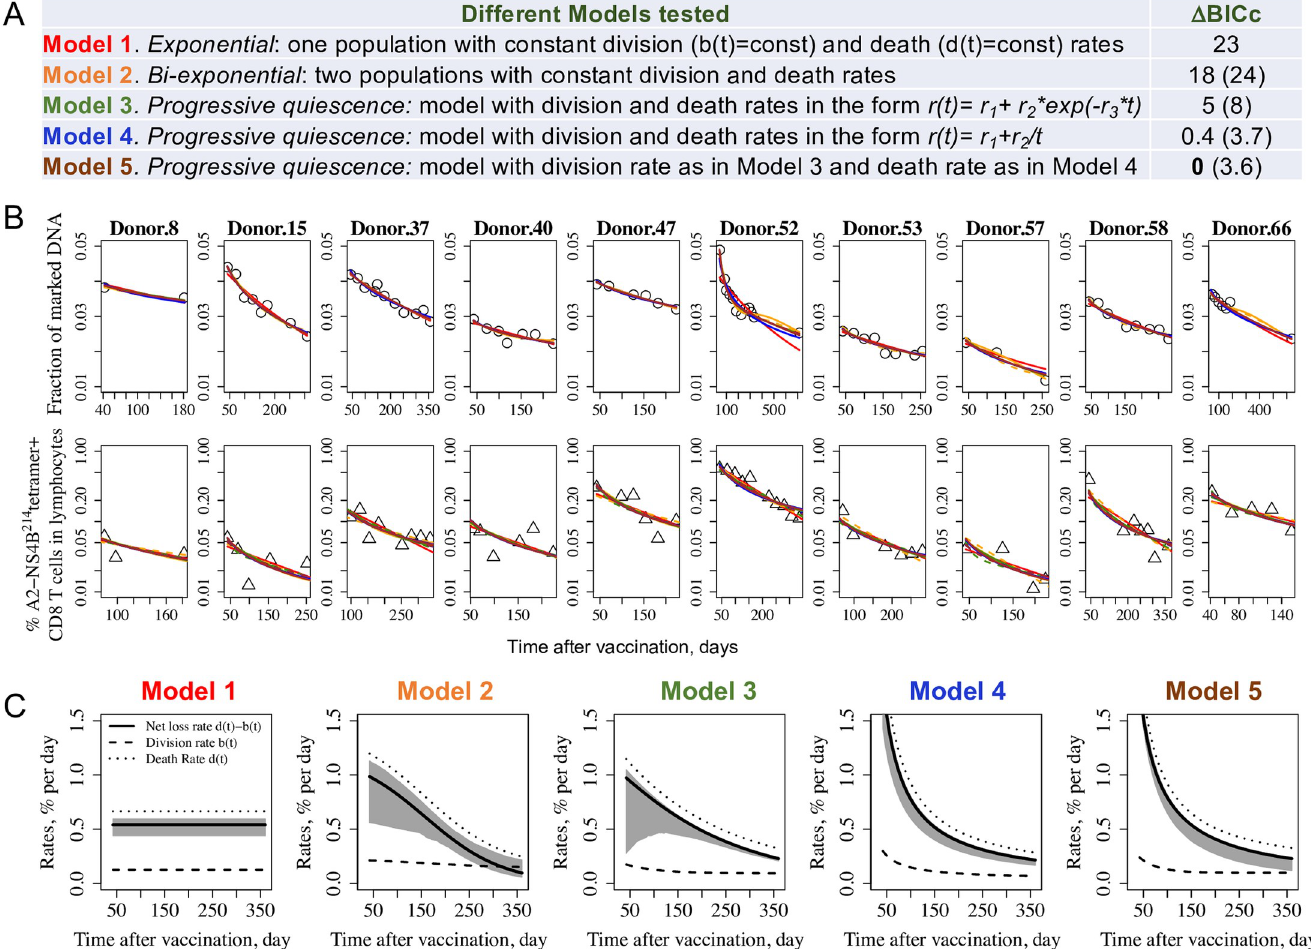
Fig 2. Models fit to changes in the tetramer positive YFV-specific CD8 T cells and their turnover over time. Panel A shows models describing different scenarios for changes in the division and death rates, b(t) and d(t), respectively, with time. In the simplest model (Model 1), the division and death rates are constant. Model 2 has two populations of cells with two different sets of constant division and death rates. In Models 3–5, the division and/or death rates can change from an initial value at day 42 to an asymptotic value long-term. Model 3 has both division and death rates as r ( t ) = r 1 + r 2 exp ( − r 3 t ). Model 4 has both division and death rates modeled as r 1 + r 2 / t and corresponds to a decline in number of T cells described by a power law, a functional form that captured the waning of antibodies to pertussis [29]. Model 5 has division rate as in Model 3 and death rate as in Model 4. We use a non-linear mixed effect modeling framework and the BICc information criteria [28] to examine how well these models fit the data from Akondy study [24, 30]. Models 2–5 have parameters restricted such that the asymptotic division and death rates equal each other ( restricted models). Δ BICc values are shown for these models in relation to the best fit Model 5. Δ BICc for unrestricted versions of these models (long-term division and death rates are not restricted to be equal to each other) are shown in parentheses. Panel B shows how Models 1 (red line), Model 2 (orange line), Model 3 (green line), Model 4 (blue line), and Model 5 (brown line) capture both the change in the total number of cells (data—triangles) and the deuterium labelling (fraction of marked DNA, data—circles) for each individual. Solid lines correspond to the models with long-term division and death rates equal to each other and dashed lines correspond to the same models with unrestricted parameters (no requirement for long-term balancing in division and death rates). Panel C shows the predictions of models shown in Panel B for the division rate, death rate and overall net loss rate (i.e. death rate − division rate) and depicts the population average as obtained with the mixed effect approach. The 95% CI for the net loss rate is shaded in grey (see Methods section). Distribution of individual parameters for Models 1–5 are shown in S9– S13 Figs, and Visual Predictive Checks are shown in S7 and S8 Figs (see